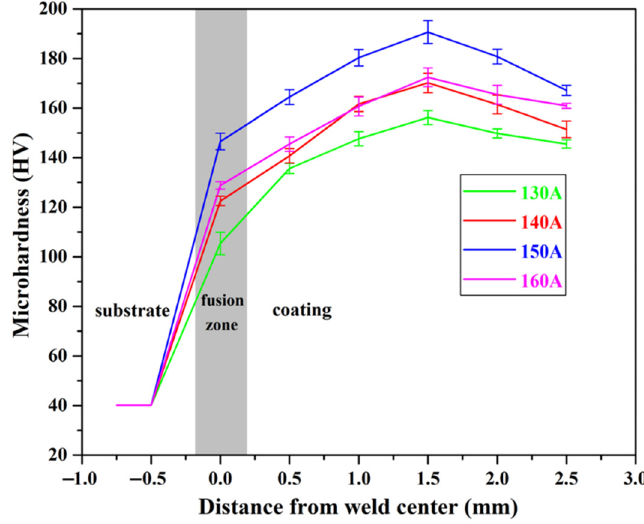
Figure 9. Microhardness of the Cu35Ni25Co25Cr15 HEA coatings deposited under different welding currents.